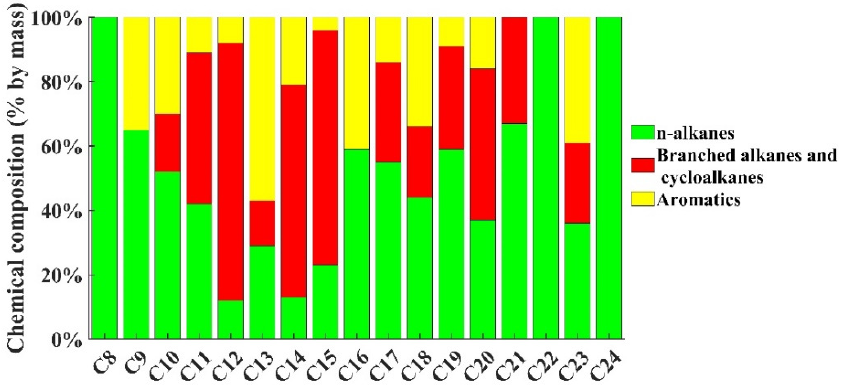
Figure 3. Distribution of n -alkanes, branched alkanes, cycloalkanes, and aromatic hydrocarbons versus the number of carbon atoms (t = 138 days).